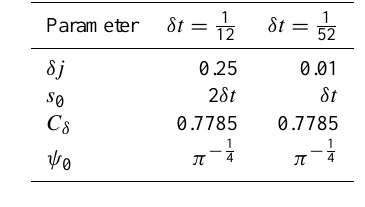
Table 1. Parameters used by the control wavelet transform for monthly and weekly spectral decomposition of CO 2 mole